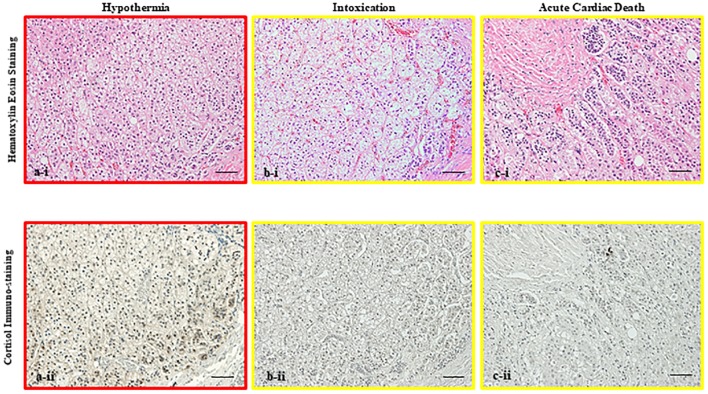
Immunostaining of cortisol in the adrenal gland.Micrographs showing hematoxylin-eosin staining (i) and immunostaining (ii) of cortisol in the adrenal gland in cases of (a) hypothermia (45-years-old male, postmortem period <28 h), (b) intoxication (27-years-old male, postmortem period <20 h) and (c) acute cardiac death (68-years-old male, postmortem period <40 h) (original bar 100 μm, respectively). In hypothermia cases, the cortisol positivity rates in the nucleus and nucleus to cytoplasm were higher than with other cause of death. Cortisol positivity in the nucleus was a characteristic finding in hypothermia cases.